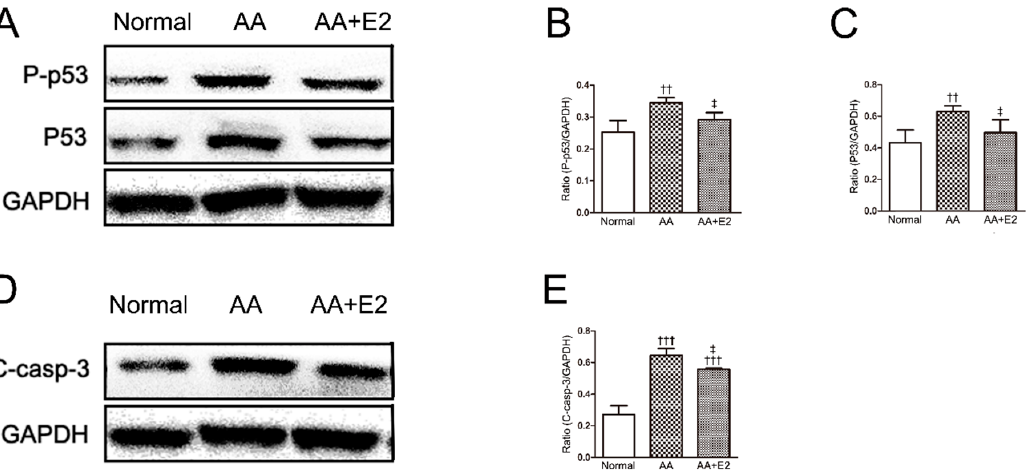
Figure 8. E2 downregulated p53 in HK-2 cells. ( A ) Phosphorylated p53 (P-p53) and p53 expression by western blotting; ( B ) Ratio between P-p53 and GAPDH measured from Western blots; ( C ) Ratio between p53 and GAPDH measured from Western blots; ( D ) Cleaved caspase-3 (C-casp-3) expression by Western blotting; ( E ) Ratio between C-casp-3 and GAPDH measured from Western blots. Data were expressed as mean ± SD for three independent experiments. †† p < 0.01, ††† p < 0.001 vs. normal group; ‡ p < 0.05 vs. AA group.